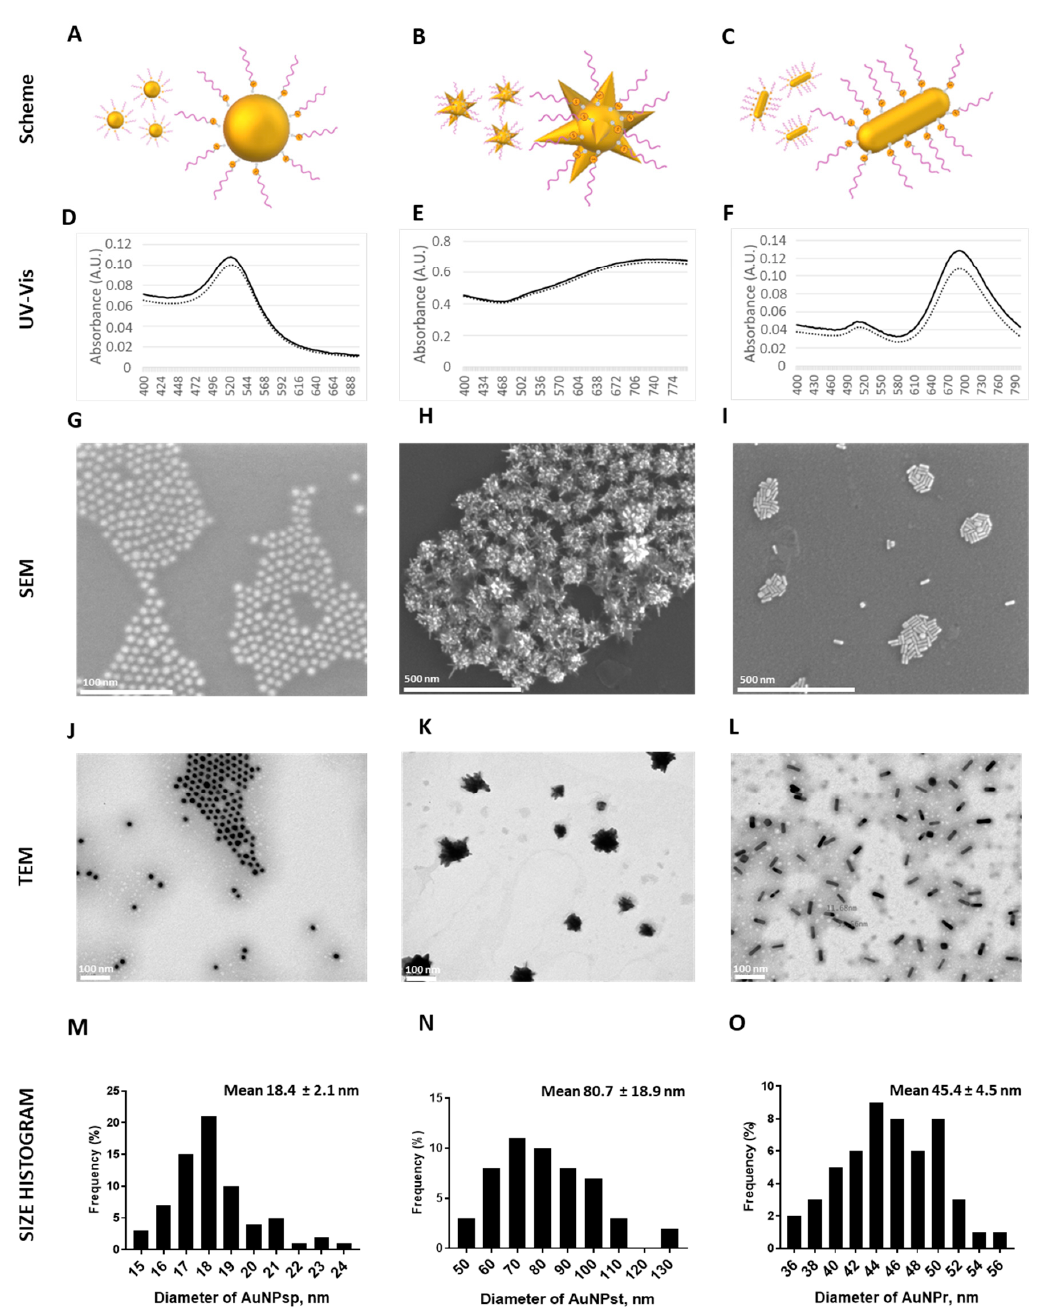
Figure 2. Characterization of PEG-coated AuNPs with different conformations of gold nanoparticles. Representative illustration of PEG-coated spherical gold nanoparticles (AuNP sp -PEG, ( A ); PEG- coated star gold nanoparticles (AuNP st -PEG, ( B ) and PEG-coated rod gold nanoparticles (AuNP r - PEG, ( C ). Characterization by UV-Vis spectra, results of AuNP sp ( D ), AuNP st ( E ) and AuNP r ( F ). The dash line means PEG-coated AuNPs, and solid line means AuNPs without PEG. Characterization by SEM of AuNP sp -PEG image scale of 100 nm ( G ), AuNP st -PEG scale of 500 nm ( H ) and AuNP r -PEG scale of 500 nm ( I ). Characterization by TEM of AuNP sp -PEG ( J ), AuNP st -PEG ( K ) and AuNP r -PEG ( L ) with PEG staining with phosphotungstic acid, image scale 100 nm. Histogram size based on TEM images of AuNP sp -PEG ( M ), AuNP st -PEG ( N ) and AuNP r -PEG ( O ), the scale of 100 nm. The histogram size was obtained by counting over 50